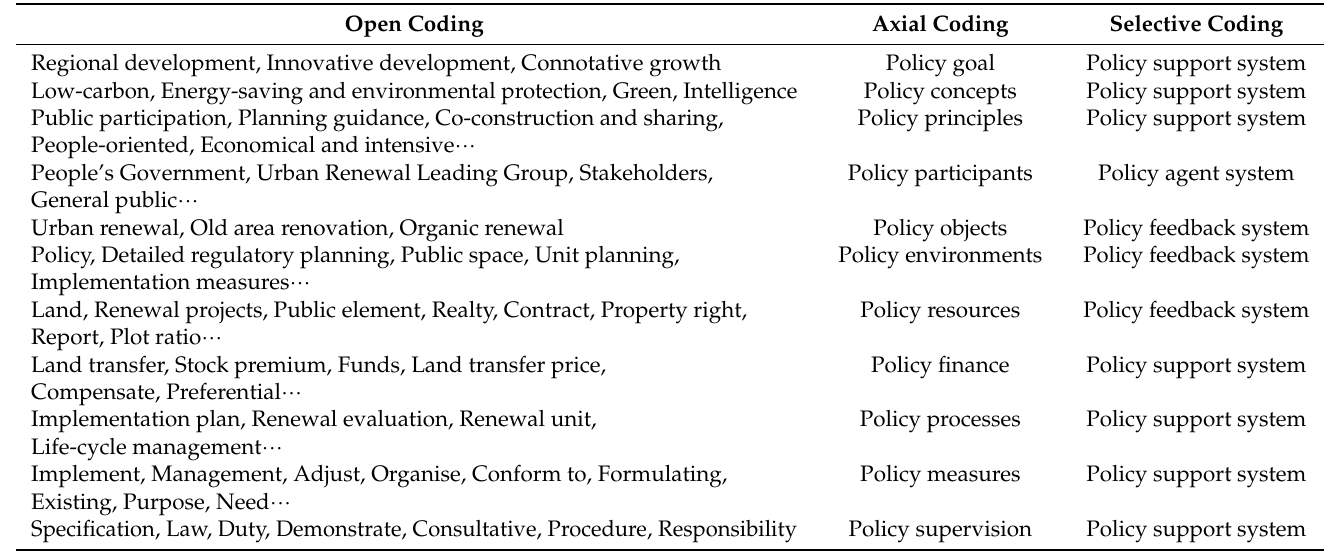
Table 5. Axial coding and selective coding table (Shanghai).